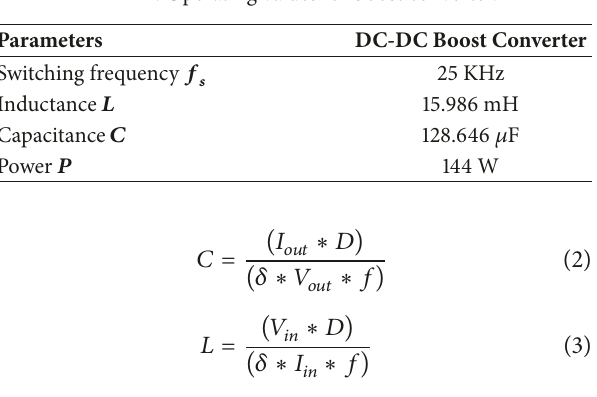
Table 1: Operating values for boost